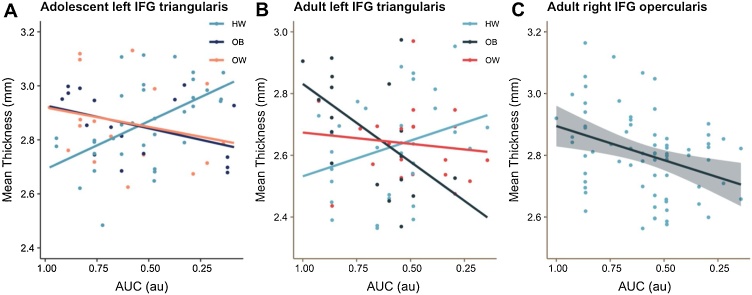
Delay discounting is related to decreased IFG thickness in both adolescents and adults with greater adiposity. A) DD moderated the relationship between BMI and left IFG thickness in adolescents and B) adults; participants with elevated adiposity and DD had reduced IFG pars triangularis thickness. C) DD was negatively correlated with right pars opercularis thickness in adults only. Area under the curve (AUC) was used to measure degree of discounting, where lower AUC represents higher DD. For illustration purposes, data have been plotted by weight group (HW = healthy weight, OB = obese, OW = overweight).